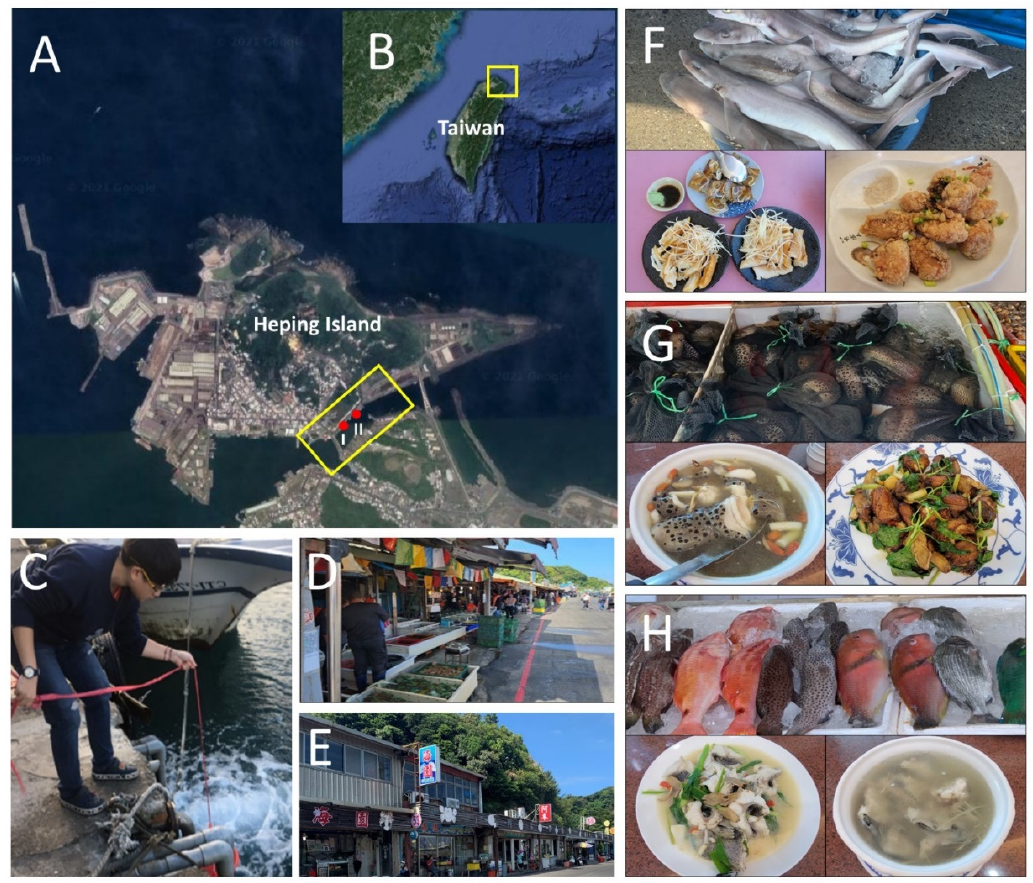
Figure 1. eDNA sampling site information: eDNA samplings were performed in the Heping Island of Keelung city in the northeastern Taiwan ( A , B ). Water samples were collected in two sampling sites ( C ) near the drains of the fish market ( D ) and its nearby seafood restaurants ( E ). Traditional seafood commonly found in sampling sites, including smoked shark ( F ), braised moray eel and Anguilliformes species ( G ), grouper fish soups and Serranidae species ( H ). The yellow rectangle indicates the region of the fish market and its nearby seafood restaurants. The red circles mark the location of two sampling sites (I,